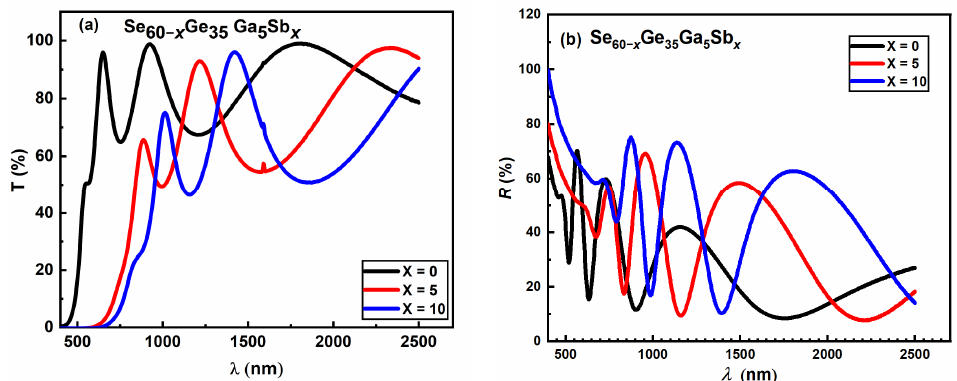
Figure 3. ( a , b ) The transmittance and reflectance spectra of the evaporated film at a thickness (450 nm).